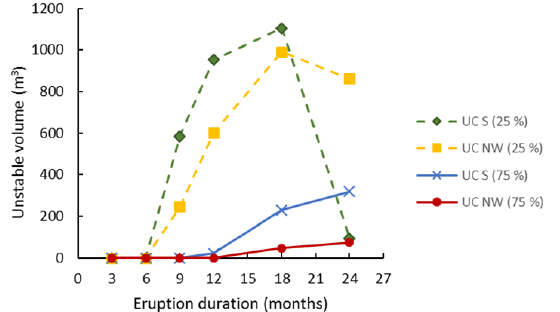
Figure 8. Unstable tephra fallout volume for the S and NW upper catchments obtained with TRIGRS for eruption durations of 3, 6, 9, 12, 18, and 24 and for probabilities of occurrence of 25% and 75%. UC: upper catchment (see Fig. 6).